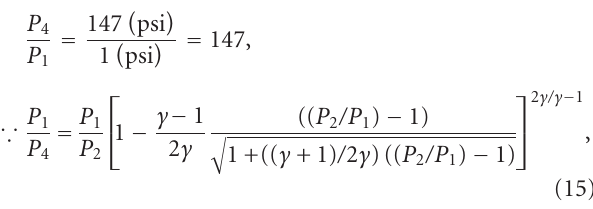
is 787.4 milliseconds in the test section. The main shock arrived at point no. 1 at t = 11 . 08 milliseconds, and